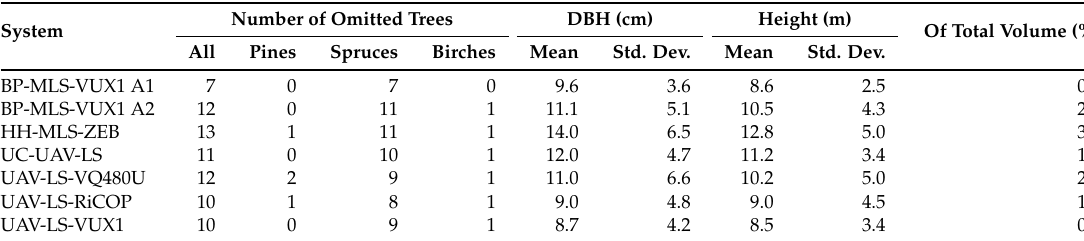
Table 9. Statistics of omitted trees for the different mobile and airborne laser scanning methods. The statistics include the omitted reference trees from both of the test sites. The last column of the table represents the total stem volume of the omitted trees as compared with the total reference stem volume on both of the test sites